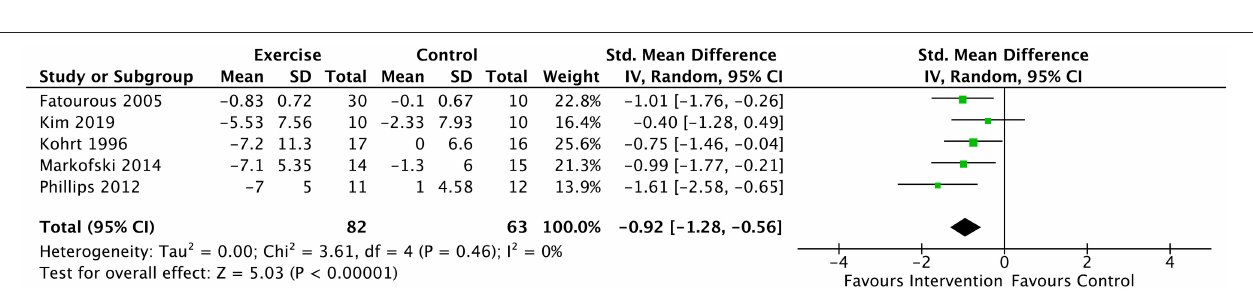
adiponectin data revealed no significant intervention